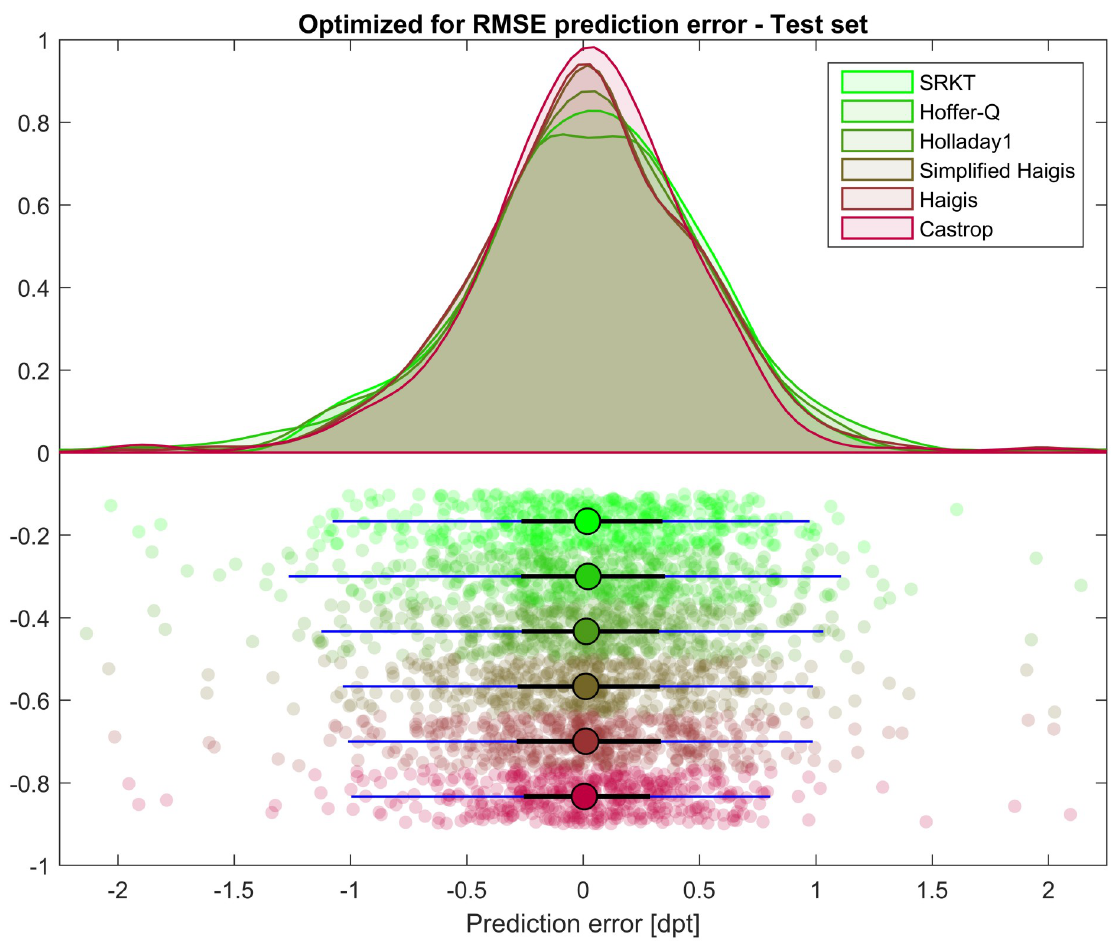
Fig 1. Prediction error PE as the deviation of achieved spherical equivalent from the formula predicted refraction. Formula constants have been optimized on the training dataset (N = 1017) and cross-validated on the test set (N = 435). The upper part of the plot shows the approximated kernel density distribution for the 6 formulae under test, and the lower part the scatter of the PE together with the median (circle), the quartiles (black line), and the 90% confidence interval (5% and 95% quantile, blue line). We see that after optimization of the formula constants on the training data none of the formulae shows a systematic offset in the prediction error. The blue lines in the lower plot representing the 90% confidence interval show that the variation on the test data is largest with the Hoffer-Q formula and lowest with the Castrop